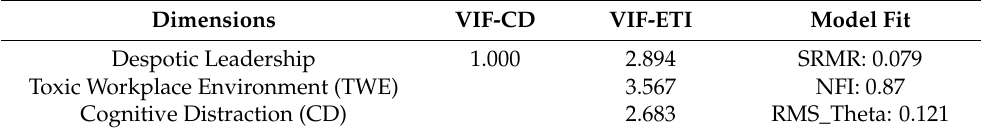
Table 4. Collinearity and model